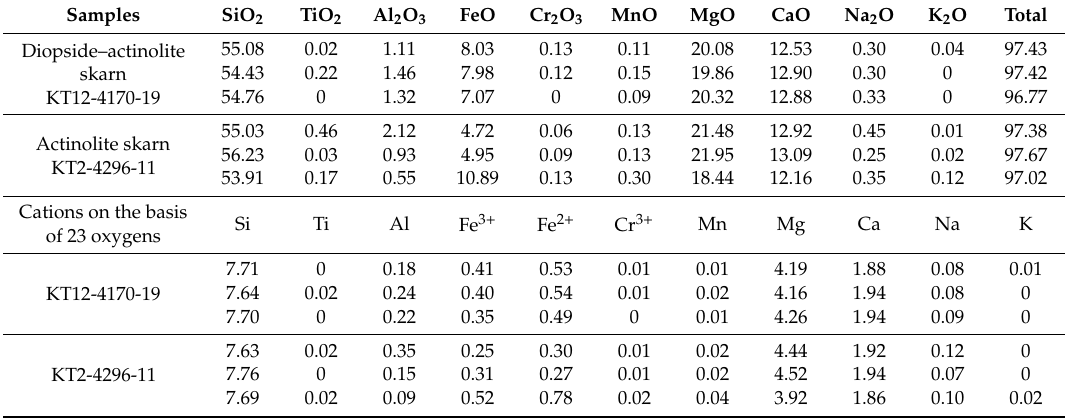
Table 5. Electron microprobe analyses of actinolite from the Hongshan deposit (wt %). Samples